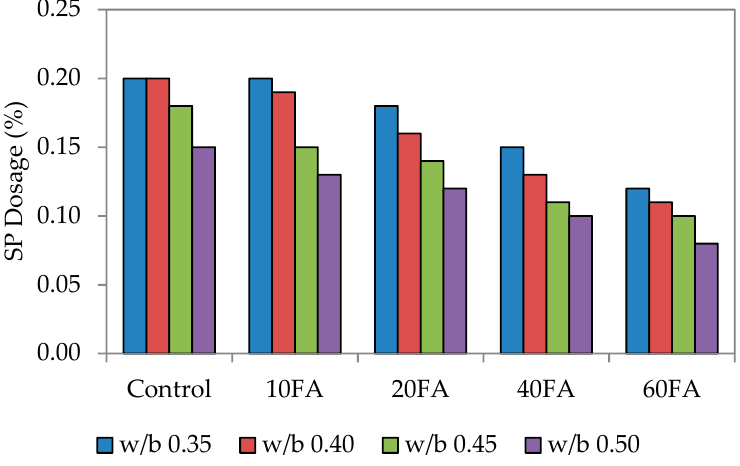
Figure 2. Superplasticizer dosage of normal flowability.